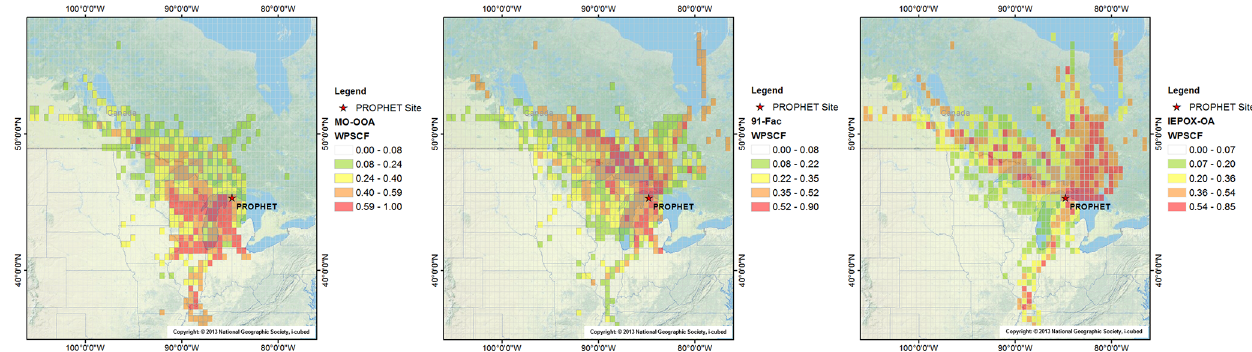
Figure 2. WPSCF backward-trajectory analysis maps for the following hourly averaged OA factors from left to right: above-canopy MO- OOA, above-canopy 91Fac and above-canopy IEPOX-OA. The geographical location of the PROPHET site is represented by a red star. WPSCF analysis is performed using HYSPLIT 2d backward trajectories, a grid cell size of 0.5 ◦ by 0.5 ◦ , and the geographical domain of the extents of the 2d backward trajectories. Median mass concentrations of above-canopy OA factors (A-MO-OOA: 0.31µgm − 3 , A-91Fac: 0.68µgm − 3 , and A-IEPOX-OA: 0.58µgm − 3 ) are used as the criterion WPSCF values. Color scales correspond to probability of source regions for each respective OA factor, and it should be noted that the range and gradation of the color scale changes between each plot. Map was generated using ArcMap10.1 using the 2013 National Geographic Society, i-cubed basemap. Copyright: © 2013 National Geographic Society, i-cubed.